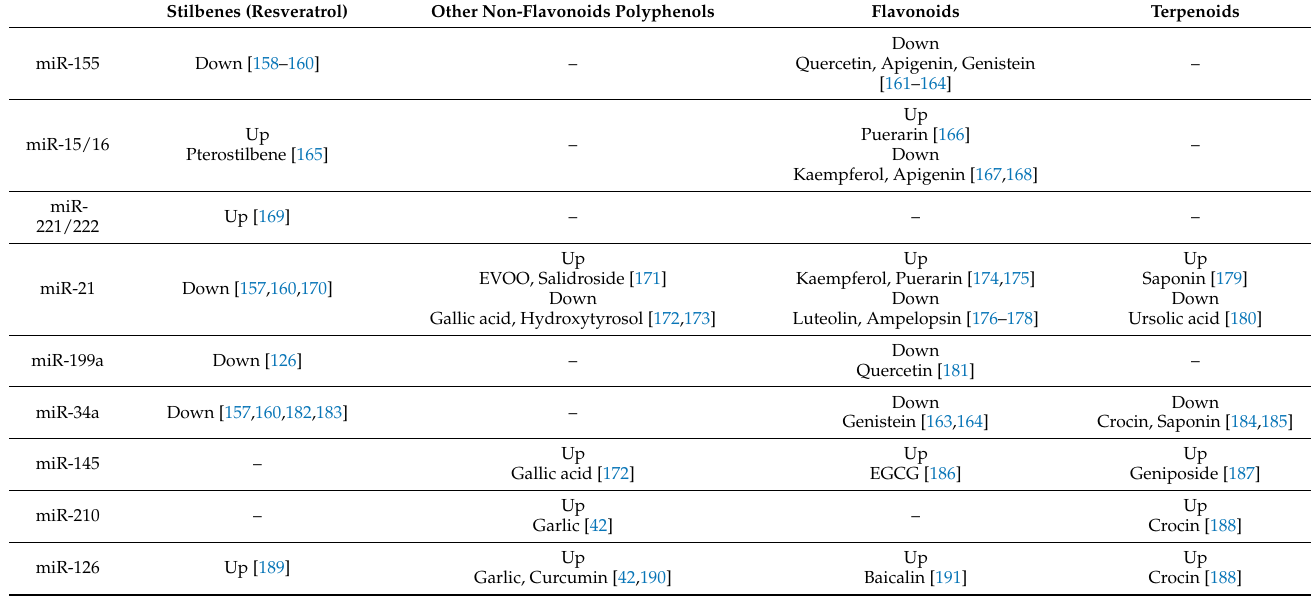
Table 2. Changes in the expression of miRNAs in CVDs by treatment with natural antioxidants. Stilbenes (Resveratrol) Other Non-Flavonoids Polyphenols Flavonoids